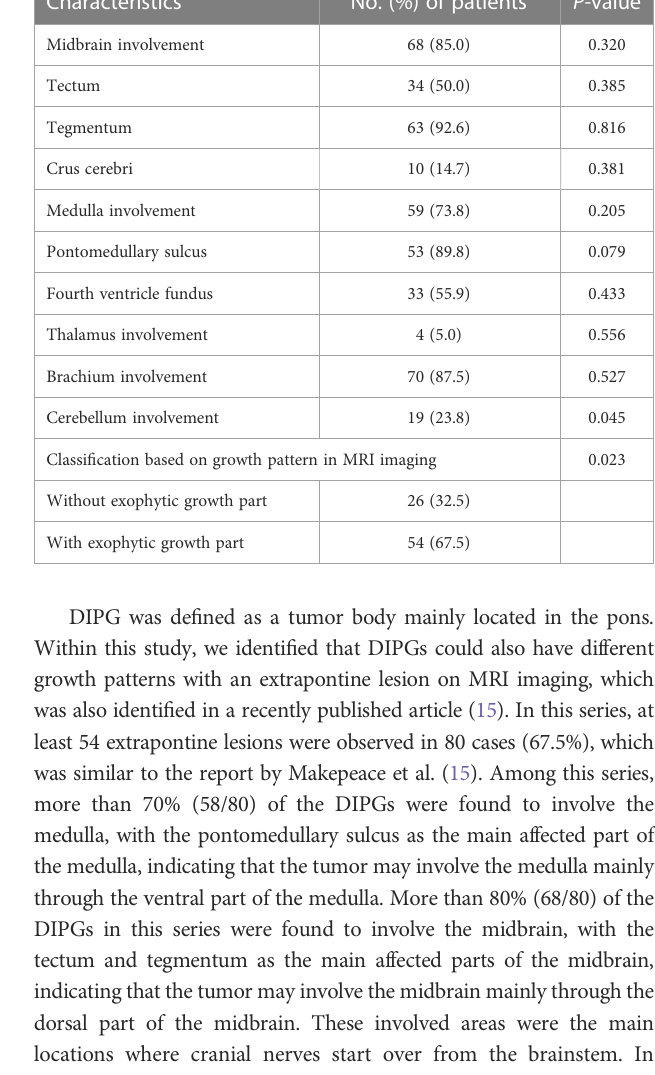
TABLE 5 Tumor growth features in MRI imaging correlated with OS of 80 DIPGs. Characteristics